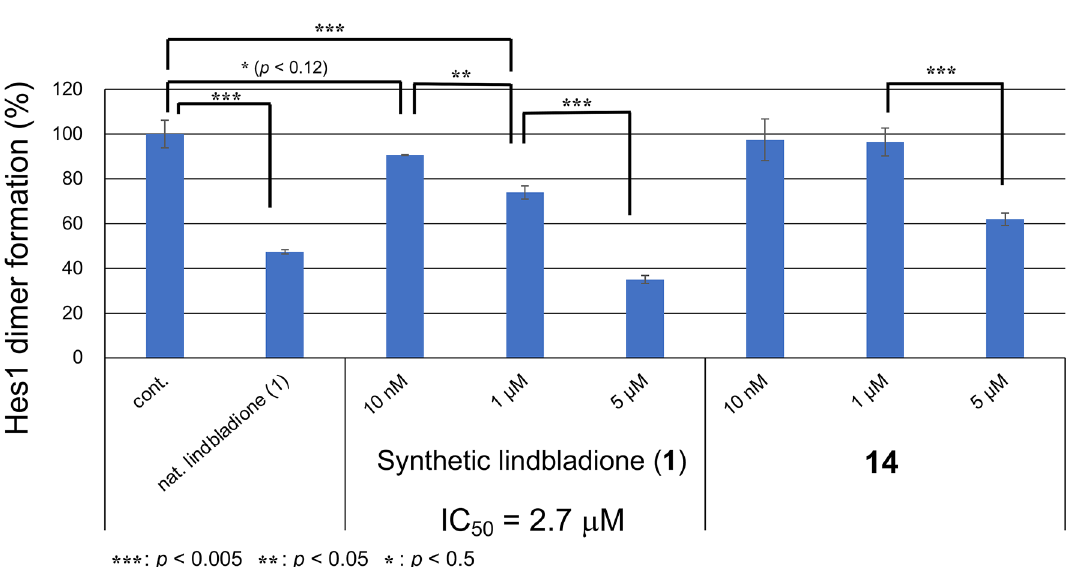
Figure 6. Inhibition of Hes1 dimer formation by isolated natural compound 1 and synthetic compounds 1 and 14 . n = 3; error bars indicate standard division; “cont.” indicates control (DMSO), “nat. lindbladione ( 1 )” indicates natural product 1 (5 μM). p values were determined using the Student’s t